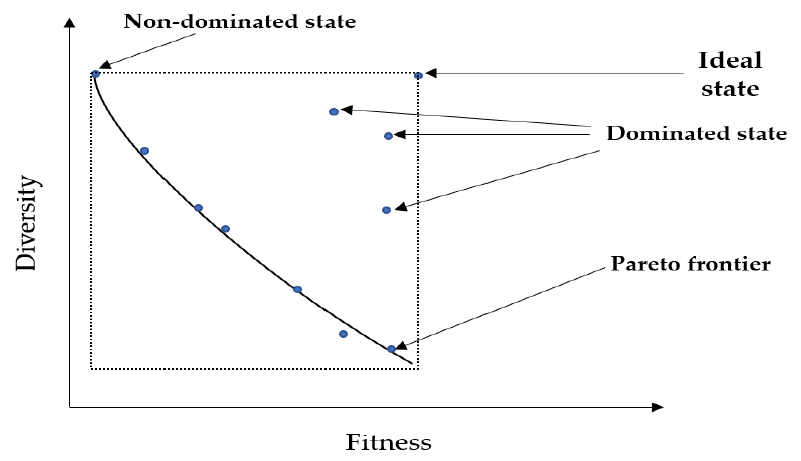
Figure 13. Sample of Pareto Frontier of a multi-objective function